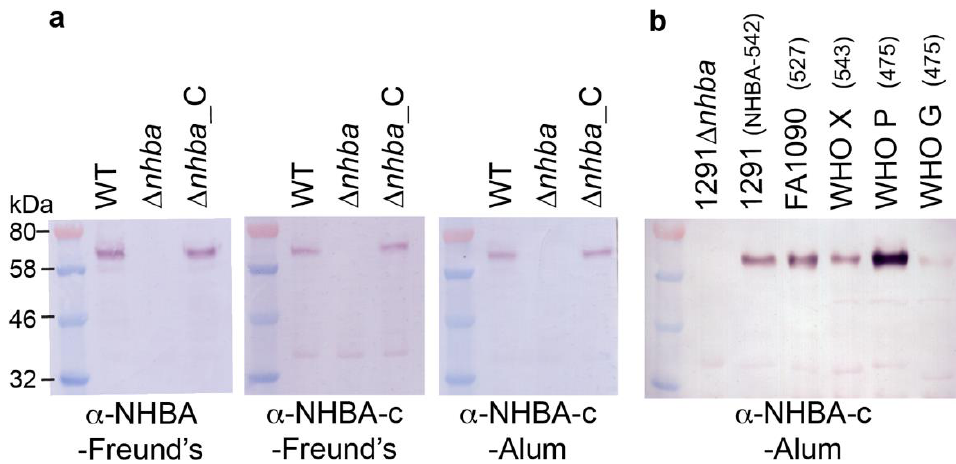
Figure 2. Expression of NHBA in a panel of gonococcal strains. Western blot analysis of